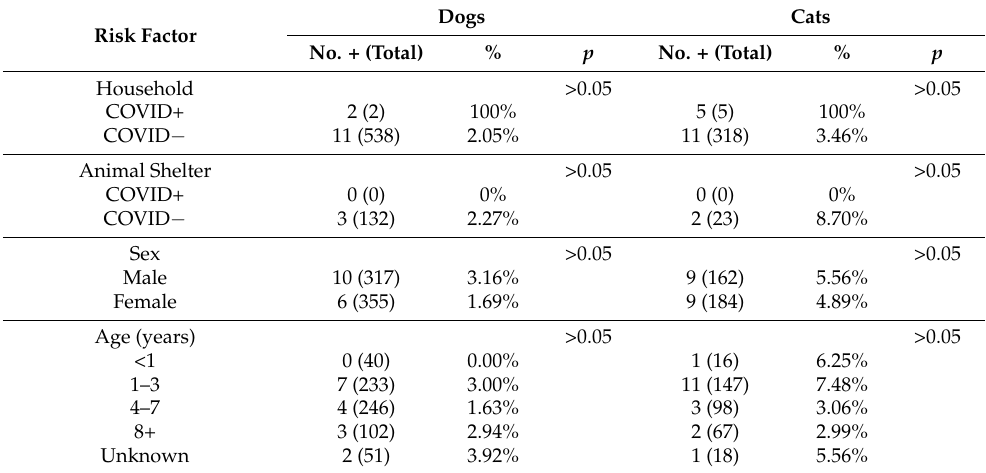
Table A2. Seropositivity among dogs and cats, split into risk factor groupings a .